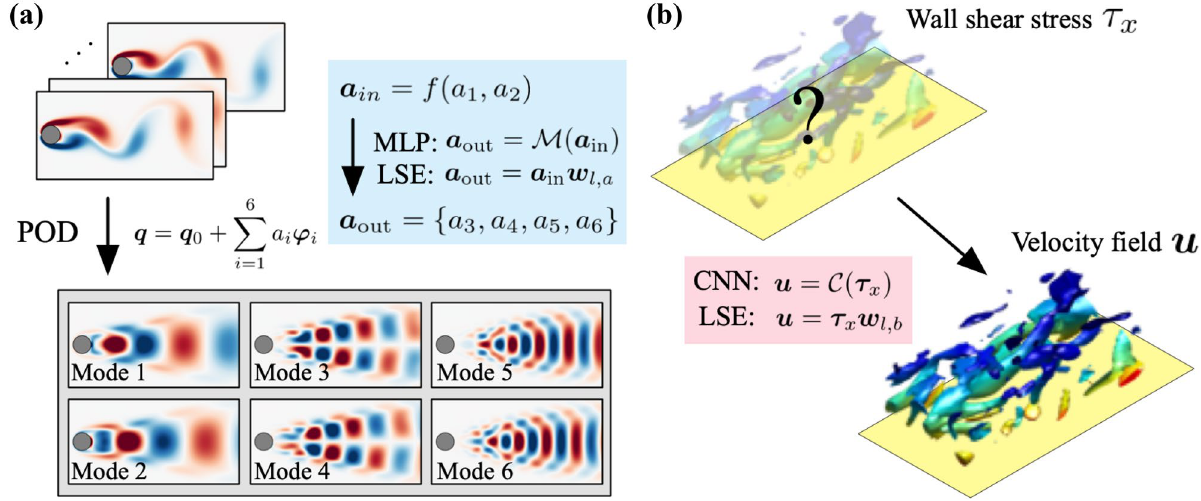
Figure 1. Covered fluid flow regressions in the present study. ( a ) POD coefficients estimation of a flow around a cylinder. ( b ) State estimation in a turbulent channel